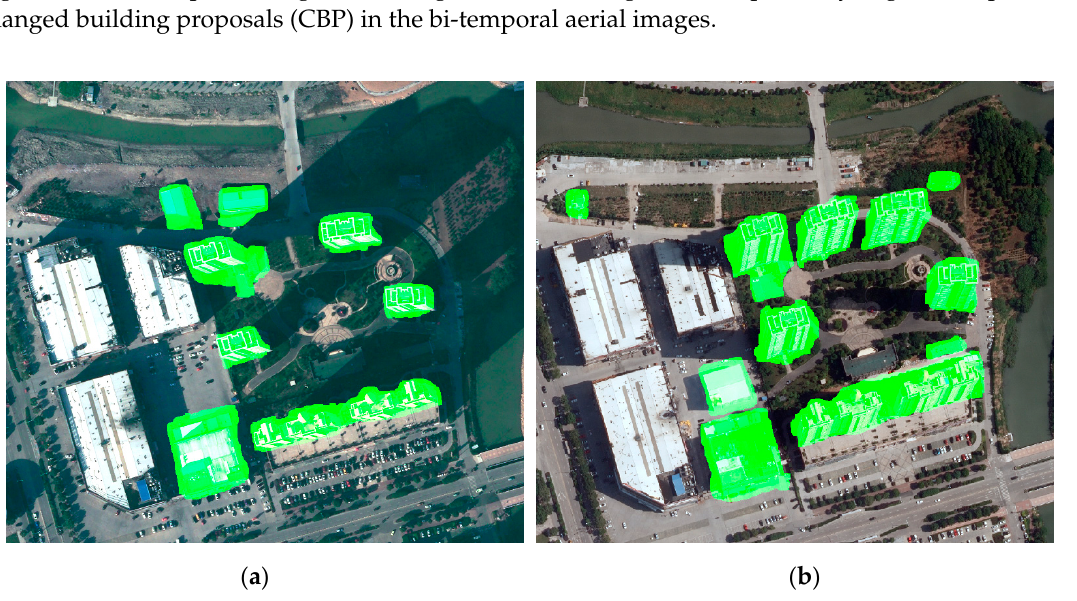
1 and ( b ) at time t